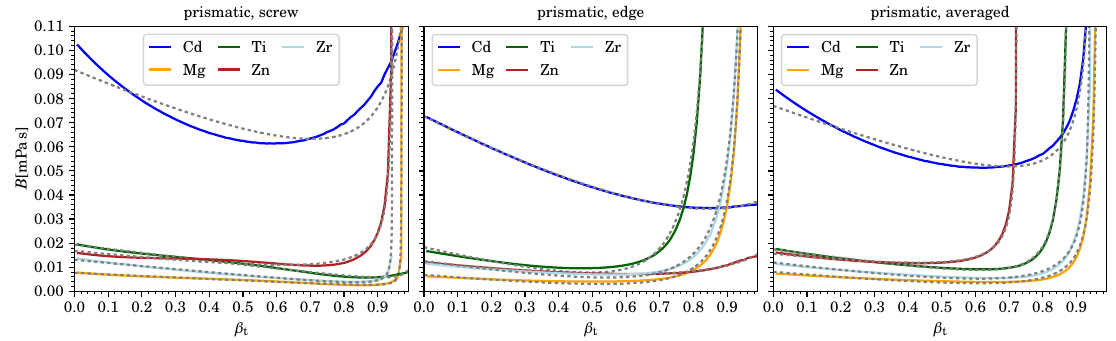
Figure 4. We show the drag coefficient B ( β T ) from phonon wind for pure screw and edge dislocations as well as averaged over all character angles ϑ for prismatic slip of five hcp metals. Dashed lines represent the fitting functions and β T = v / c T .